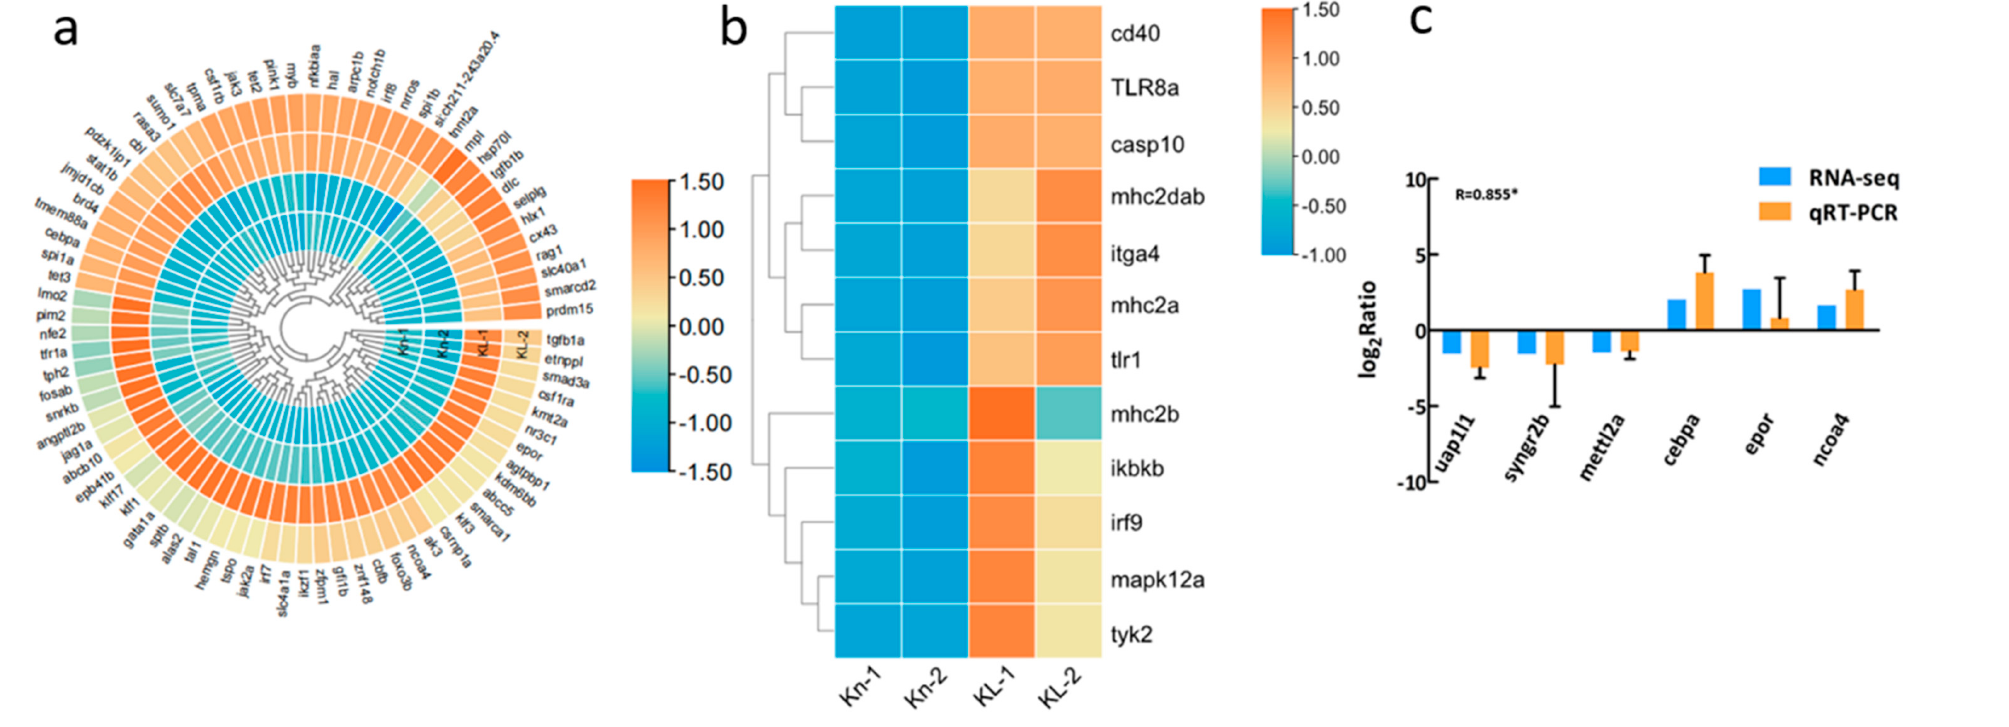
Figure 4. DEGs involved in the hematopoiesis process and immunity response and qRT-PCR results. ( a ) Heatmap of DEGs involved in the hematopoiesis process. ( b ) Heatmap of DEGs involved in the immunity response. Kn-1 and Kn-2 are the normoxia zebrafish group and KL-1 and KL-2 are the hypoxia group. ( c ) Comparison of gene expression between the RNA-seq and qRT-PCR data. The qRT-PCR results in the bar graph are shown as mean +/- standard deviation. The Pearson correlation coefficient (R) was used to measure the correlation between RT-qPCR and RNA-seq results. Moreover, * indicates significant correlation ( p < 0.05).